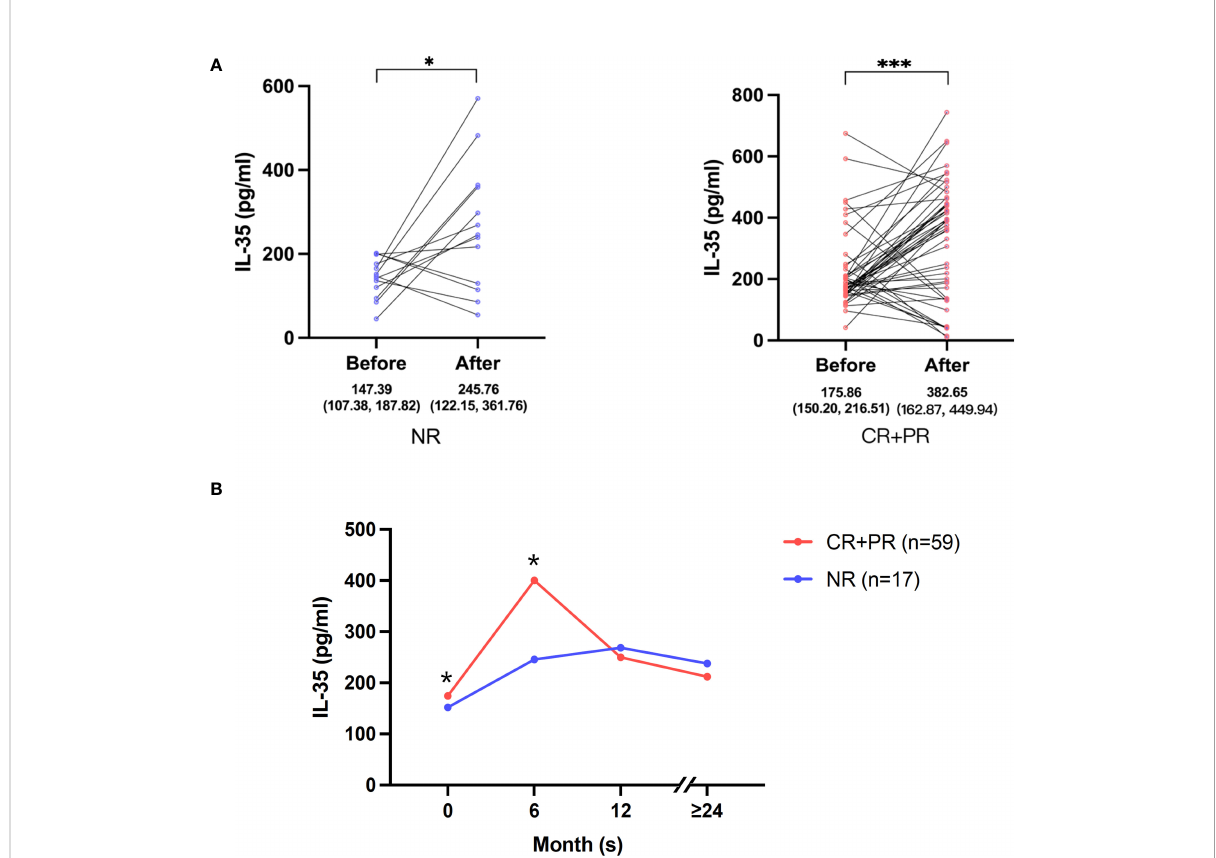
FIGURE 3 Changes of serum IL-35 levels of IMN patients (A) Serum IL-35 levels of each patient at baseline and follow-up endpoint wereconnected inparallel. IMN patients weredivided into two groups according to the disease: no remission (NR) and remission(CR+PR). A Wilcoxonmatched pairs signed rank test was usedto compareIL-35 levels performed onthe same IMNpatientsduringactive disease andin remission. *represent P <0.05, *** represent P <0.001. (B) Dynamic changes ofserum IL-35 in IMN patients at 0, 6,12, 24months and above afterMFSDtreatment. IMN patients weredividedinto two groups accordingtothe disease: noremission(NR)(n=17) and remission(CR+PR)(n=59). The data is expressed by median. *represent P